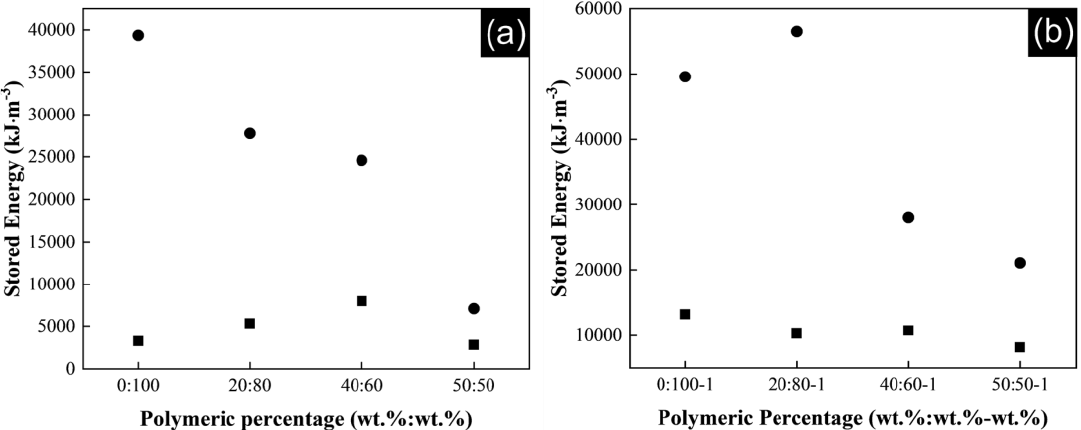
Figure 9. Stored energy up to breaking for composite yarns: ( a ) P(S:AN) and ( b ) P(S:AN-AA), with different CNTs contents: ( ∎ ) 0.5 wt.% and ( ● ) 1.0 wt.%. The relative error is 5%.